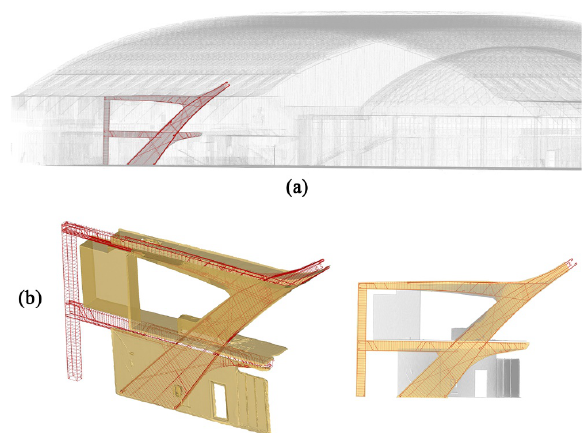
Figure 5 . (a) Integration of the extrados of the P12 pillar module surveyed by reality-based model. (b) 3D models of the internal structural elements developed from the design phase.